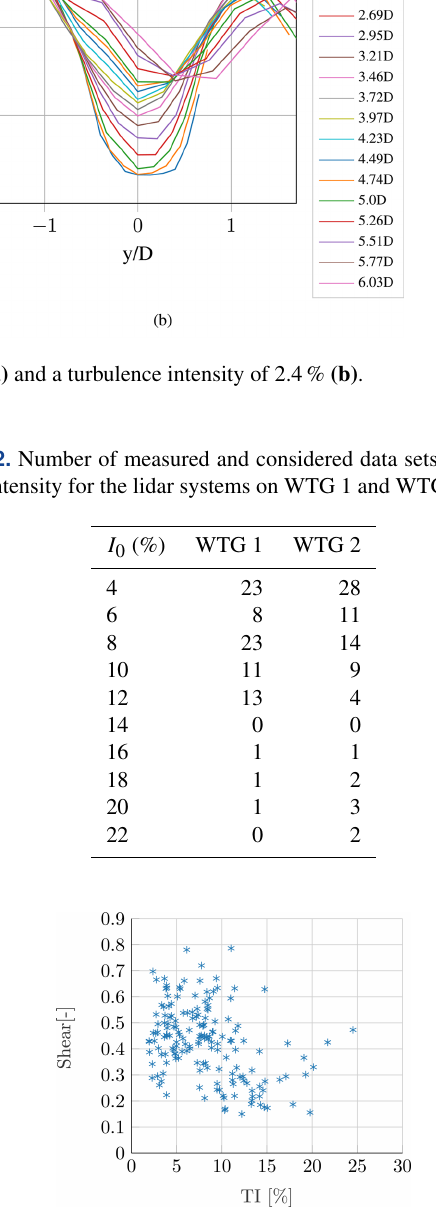
Figure 11. Shear exponent over the ambient turbulence intensity for all considered data